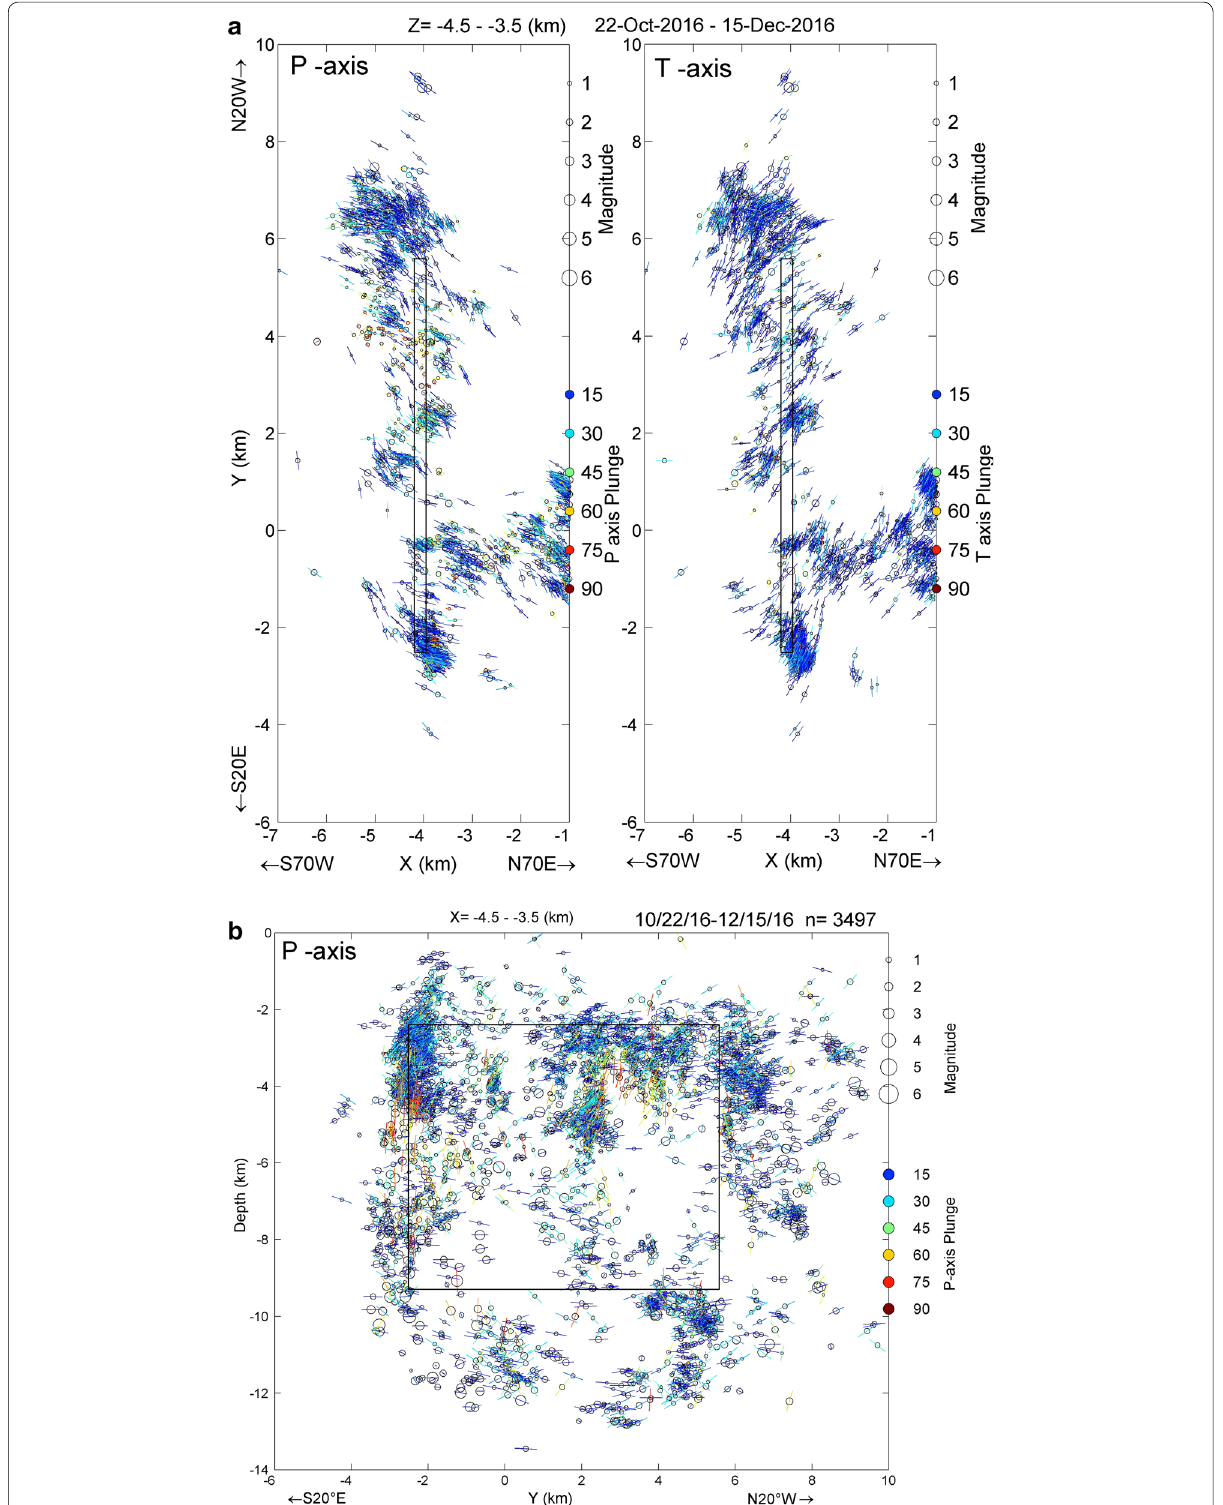
Fig. 2 Orientation of P- and T-axes of optimal focal mechanisms. a P- and T-axes of aftershocks located at 4 plane. b P-axes of aftershocks located within 0.5 km from the mainshock fault projected onto the vertical cross section along the fault. The plunge of each axis is indicated by axis color. Rectangles show the mainshock fault estimated from InSAR and GNSS data assuming uniform slip (GSI